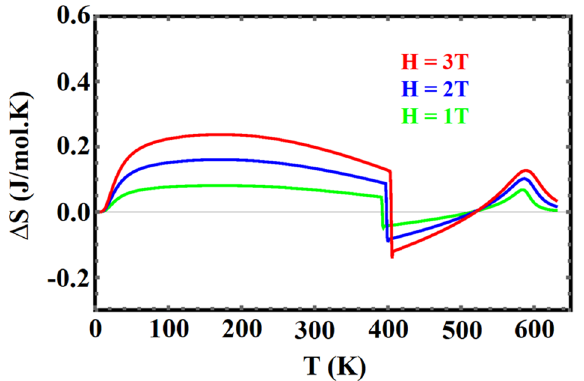
Figure 11. Temperature dependence of isothermal change in entropy for HoFe 3 in fields of 1, 2 and 3 T.